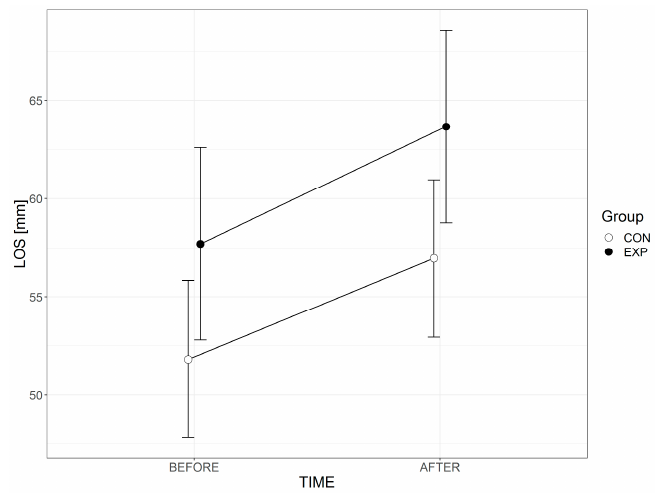
Figure 1. Graphical representation of the results of LOS. Table 4. Mean values and standard deviations of CI parameter.